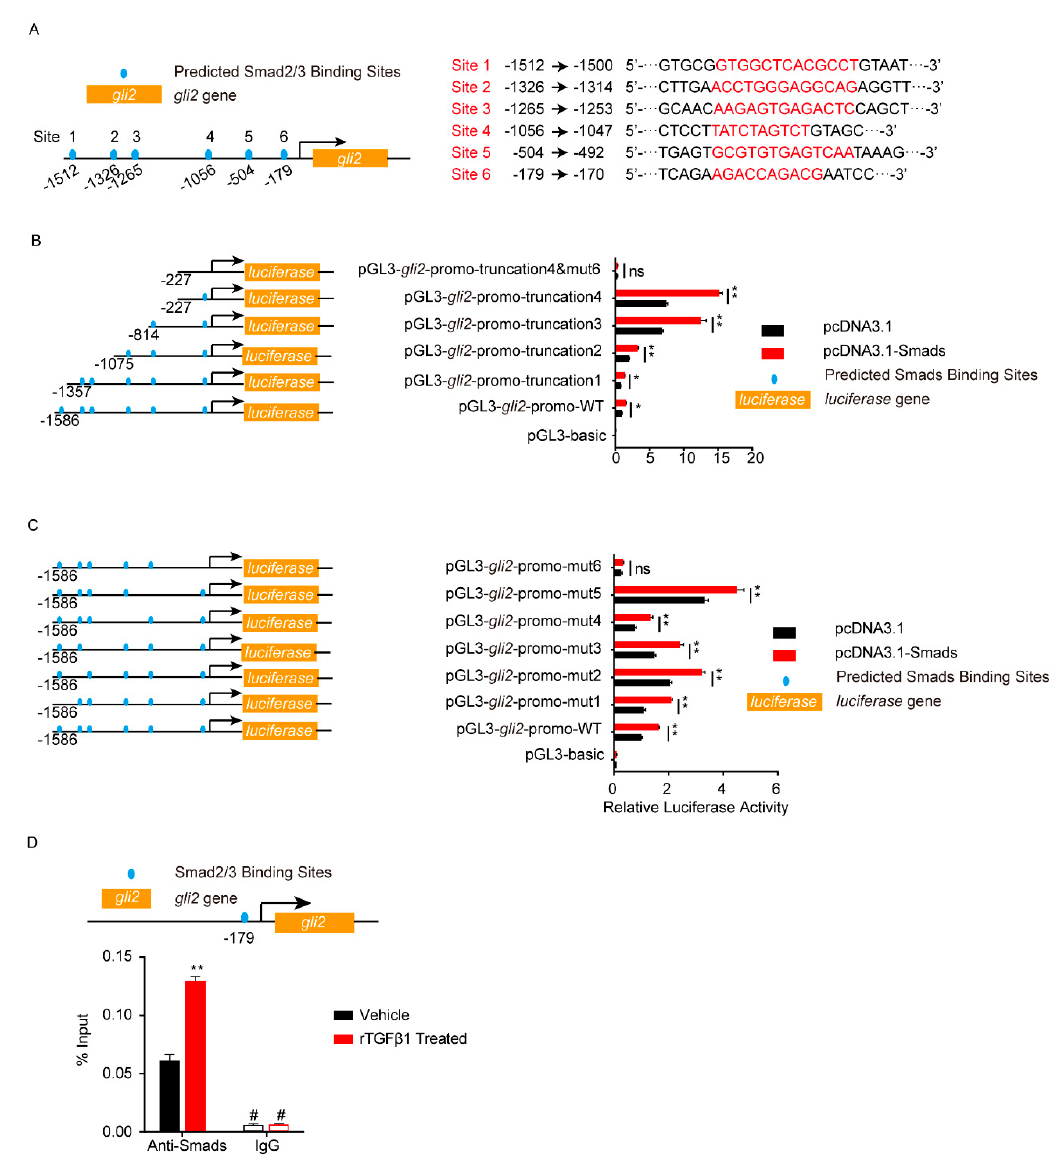
Figure 5. Analysis of Smad2/3 binding sites on gli2 promotor by dual-luciferase reporter assays. ( A ) Schematic of the 6 predicted Smad2/3 binding sites on gli2 promotor (left) and their binding sequences accordingly (right). The binding sites were located at − 1512 to − 1500 (site 1), − 1326 to − 1314 (site 2), − 1265 to − 1253 (site 3), − 1056 to − 1047 (site 4), − 504 to − 492 (site 5), and − 179 to − 170 (site 6) of the gli2 promotor region. ( B – C ) The gli2 luciferase activity was tested by applying a series of truncations ( B ) and site-targeted mutations ( C ) to the gli2 promoter, along with pcDNA3.1-Smad2 and pcDNA3.1-Smad3 and pRL-TK plasmids. The specific constructs used in the truncation assays ( B ) included the pGL3-basic vector, pGL3- gli2 -promo-WT (containing promotor region from − 1568 to +35), pGL3- gli2 -promo-truncation1 (from − 1357 to +35), pGL3- gli2 -promo-truncation2 (from − 1075 to +35), pGL3- gli2 -promo-truncation3 (from − 814 to +35), pGL3- gli2 -promo-truncation4 (from − 227 to +35), and pGL3- gli2 -promo-truncation4&mut6 (from − 227 to +35 which lacks site 6). The specific constructs used in the site-mutation assays ( C ) included the pGL3-basic vector, pGL3- gli2 -promo-WT (containing all 6 sites), pGL3- gli2 -promo-mut1 (lack of site 1), pGL3-gli2-promo-mut2 (lack of site 2), pGL3- gli2 -promo-mut3 (lack of site 3), pGL3- gli2 -promo-mut4 (lack of site 4), pGL3- gli2 -promo mut5 (lack of site 5), and pGL3- gli2 -promo-mut6 (lack of site 6). The luciferase activities were determined, and are presented as the ratios of firefly luciferase activity and renilla luciferase activity. The assays were performed with 3 replicates, and data are presented as mean ± SEM. * p < 0.05, ** p < 0.01. ns, no significance. ( D ) ChIP-qPCR validation of the Smad2/3 binding to the gli2 promotor around − 179 in hBMECs treated by TGF β 1 (50 ng/mL). ChIP was performed with anti-Smad2/3 antibody and rabbit IgG was employed as the negative control. # indicates lower than the detection limits. ** p <